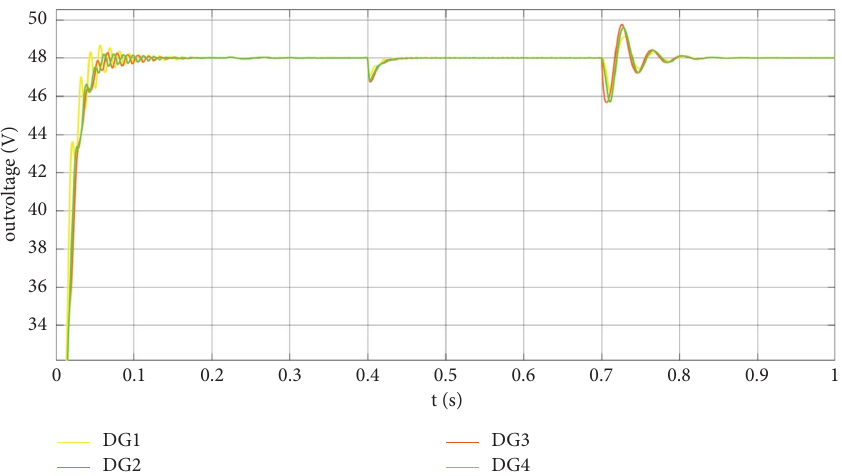
Figure 15: Output voltage with the scheme in [15].